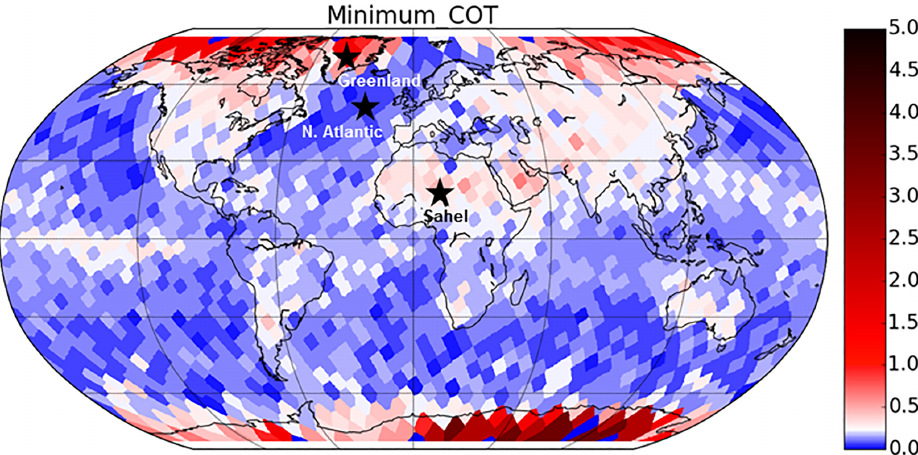
Figure 12. Global map of estimated cloud detection sensitivity of the cloud mask of CLARA-A2 (see text for explanation). Results are calculated from the same data set as visualized in Fig. 2 but in a coarser Fibonacci grid resolution of 300km. Conditions in the three marked locations (black stars) are analysed further in Fig. 13. Values below the global mean value of 0.225 are coloured in shades of blue and values above the global mean value are coloured in shades of red.